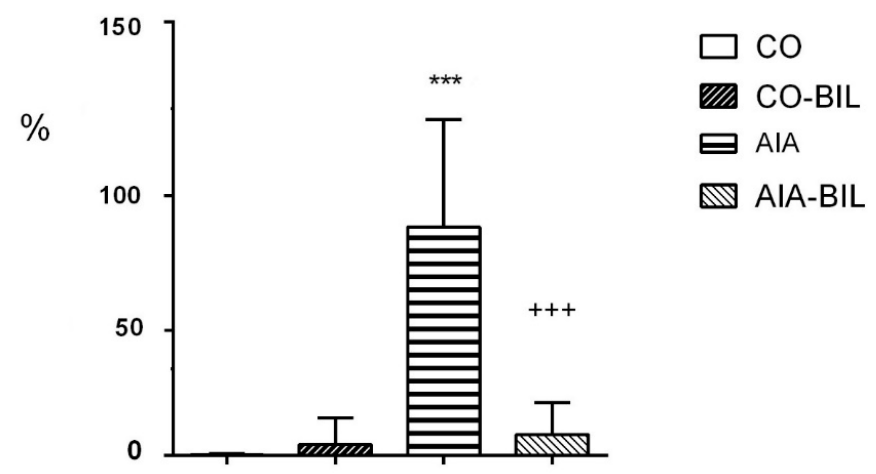
Figure 4. Infiltration of joints by granulocytes. CO—control group, CO ‐ BIL—control group administered with UCB 200 mg/kg of body weight daily i.p. from day 14, AIA—group with adjuvant induced arthritis, AIA ‐ BIL—group with adjuvant induced arthritis administered with UCB 200 mg/kg of body weight daily i.p. from day 14. Results are expressed as mean ± SEM, n = 7–8. Significant difference between groups CO and CO ‐ BIL, CO and AIA: *** p < 0.001 vs. CO. Significant difference between groups AIA and AIA ‐ BIL: +++ p < 0.001 vs. AIA.